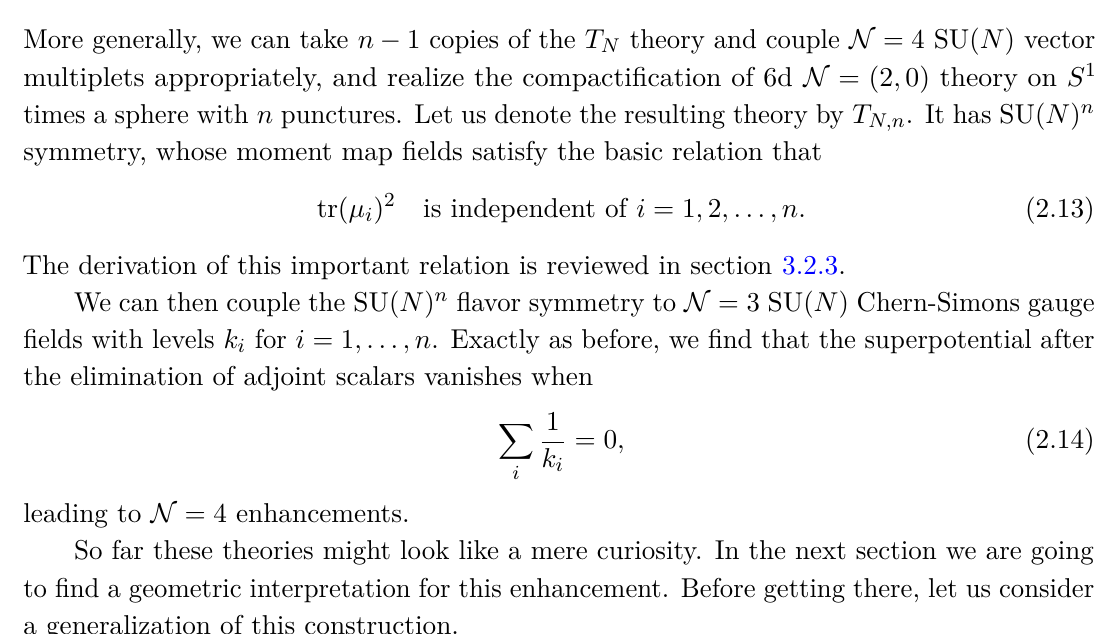
× SU( N ) k × SU( N ) k 1 2 3